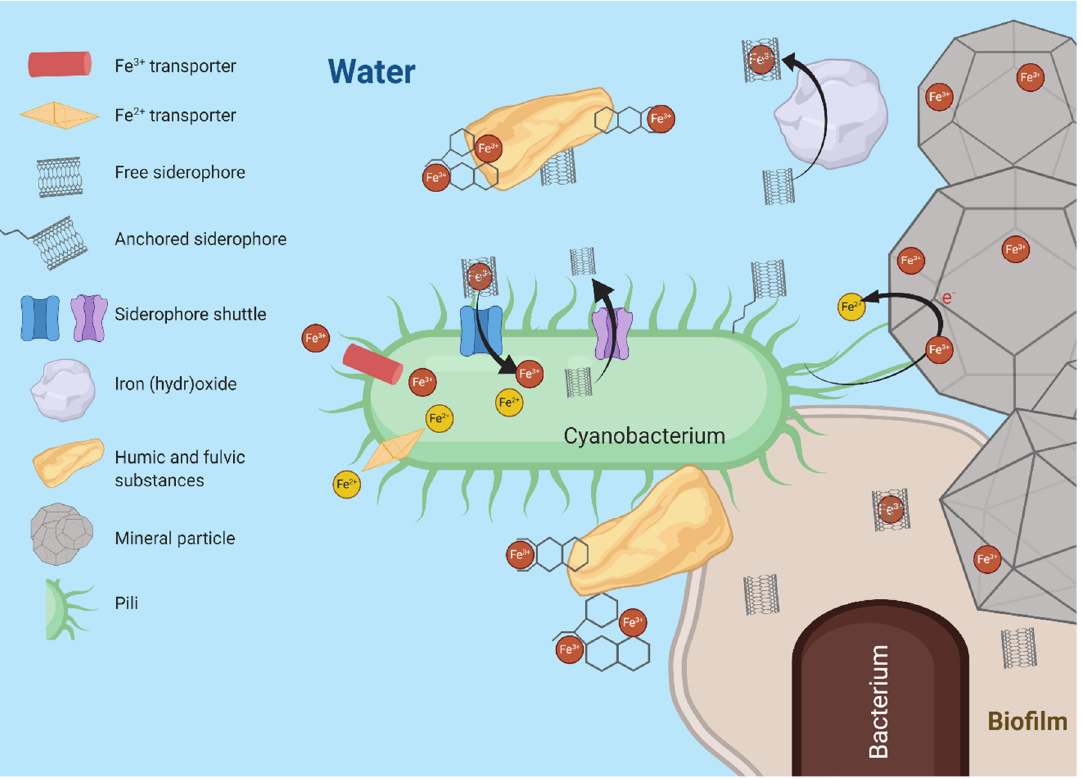
Figure 2. Schematic representation of marine cyanobacterial iron metabolism in relation to sources of iron. The cyanobacterium can either be free-living, represented as directly interfacing with the water (top left), or affiliated with other bacteria in a biofilm (bottom right). Iron may be available as iron oxides/hydroxides, which may be embedded in other mineral particles, or as iron complexed in humic and fulvic substances, or iron that is bound to siderophores. Free ferric and ferrous iron can be taken up by specific transport systems. Siderophores with bound iron can be taken up by the cyanobacterium with the iron released within the cell while the released siderophore is consequently re-excreted. For iron to reach the inside of the cells, two membrane systems (inner and outer membrane) have to be crossed by iron transporter proteins involved in siderophore shuttling. There are indications that a reductive step is involved in the release of iron from siderophores. A reductive mechanism has also been suggested to be active for releasing iron from extracellular iron oxides / hydroxides. Pili may aide in this process by making contact with the particles and/or directly or indirectly mediating electron transport from the cell to the iron minerals. Pili are also involved in biofilm formation, which interfaces consortia of bacteria with minerals as well as humic and fulvic components. Created with BioRender.com.